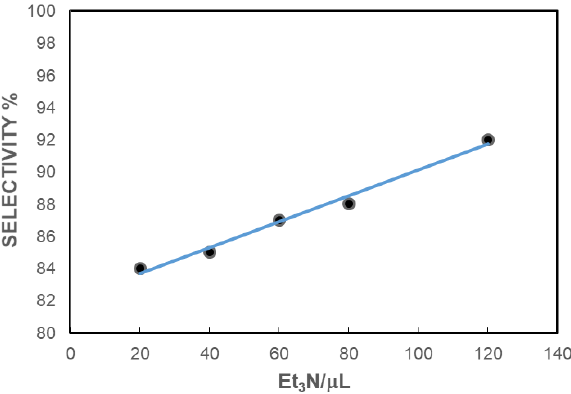
Figure 2. Optimization of the Et 3 N amount for the reductive cyclization of α -phenyl- β -nitrostyrene ( 1b ) to 2-phenylindole ( 2b ). Data from Table 2.